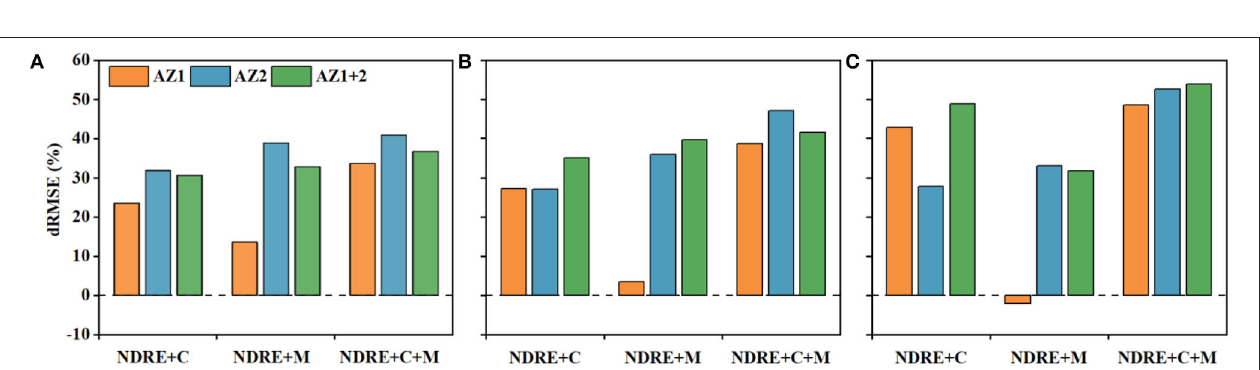
FIGURE 10 | The performance of the decrease of RMSE (dRMSE, %) of multi-source data for the aboveground biomass (A) , plant N uptake (B) , and N nutrition index (C) by combining climatic (C) factors and management (M) factors compared to normalized difference red edge (NDRE) only in agro-ecological zone 1 (AZ1), agro-ecological zone 2 (AZ2) and across two agro-ecological zones (AZ1 + 2).